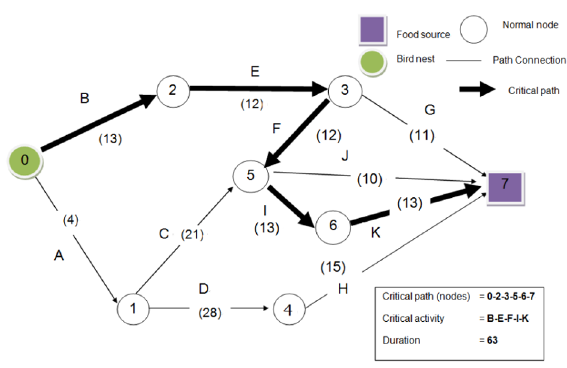
Fig. 6. New network topology for final